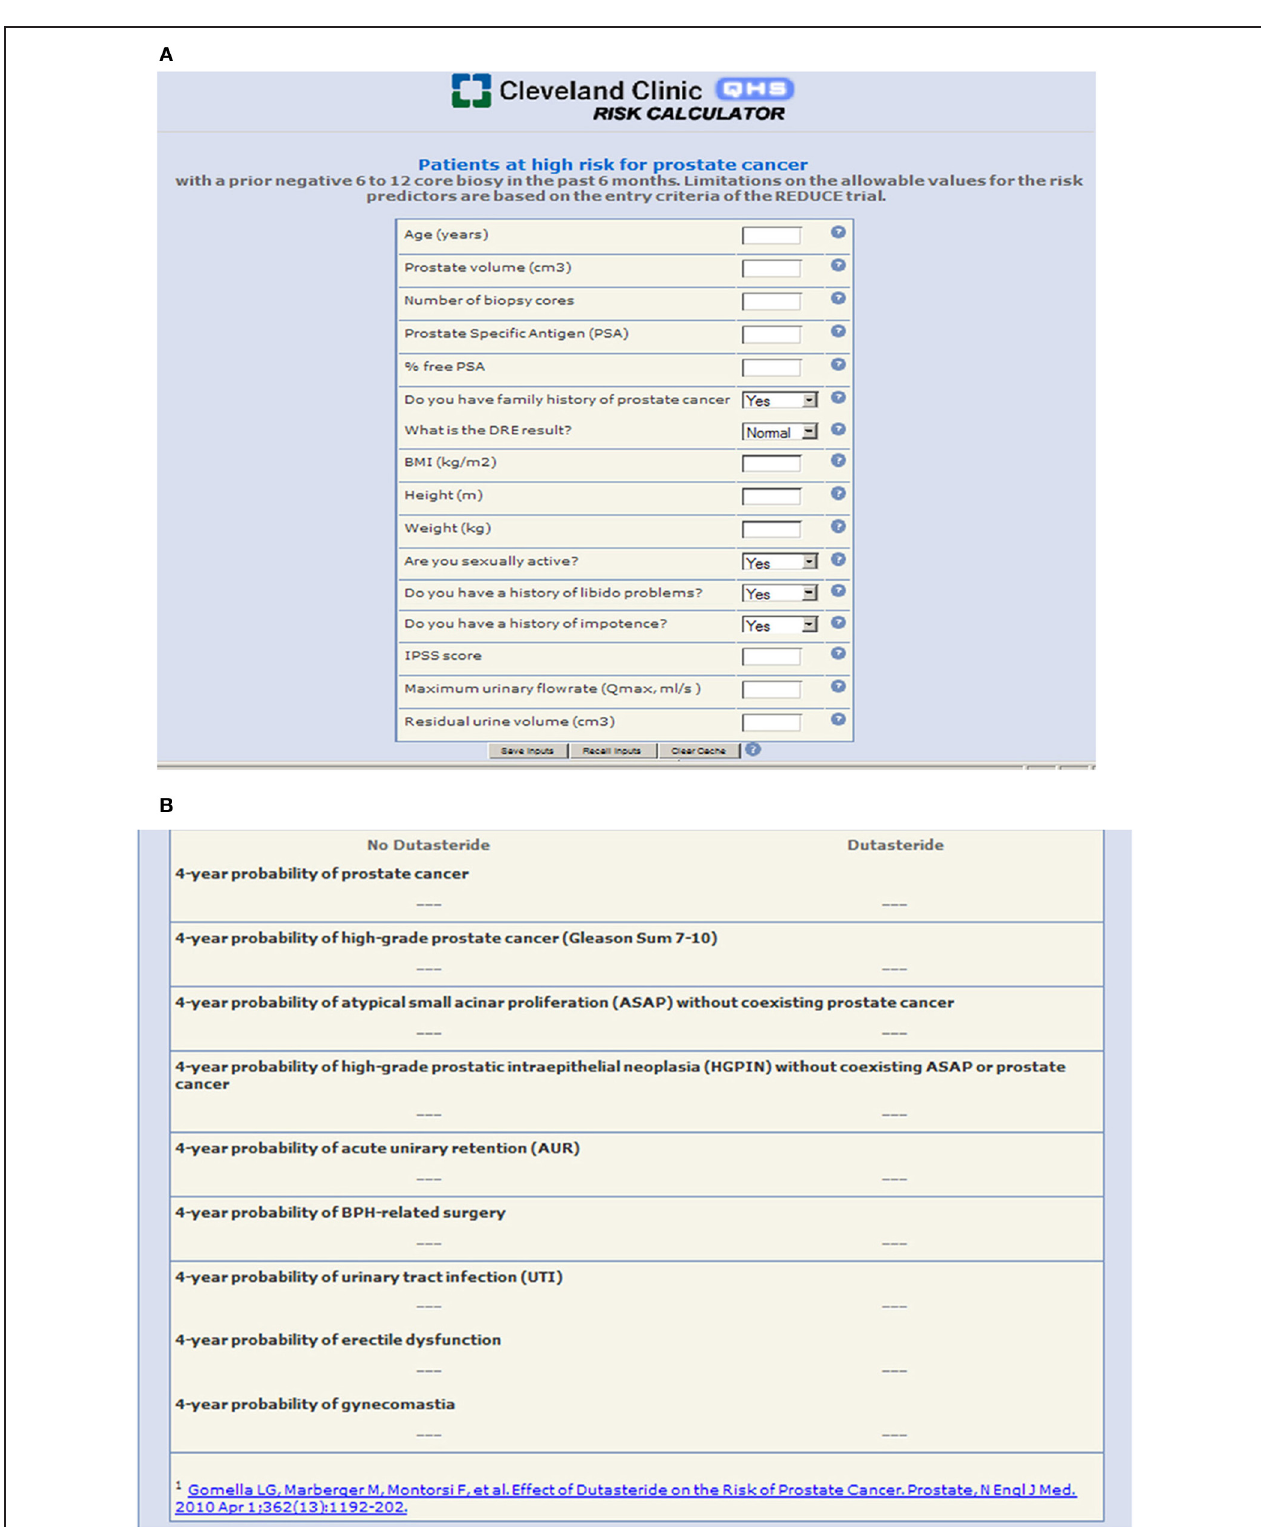
FIGURE 1 | (A) The REDUCE metagram as a user-friendly online risk calculator with “plug and play” functionality where the patient or physician can input patient-specific variables to generate predictions; (B) Individualized patient outcomes are generated and presented in a clear and concise format.